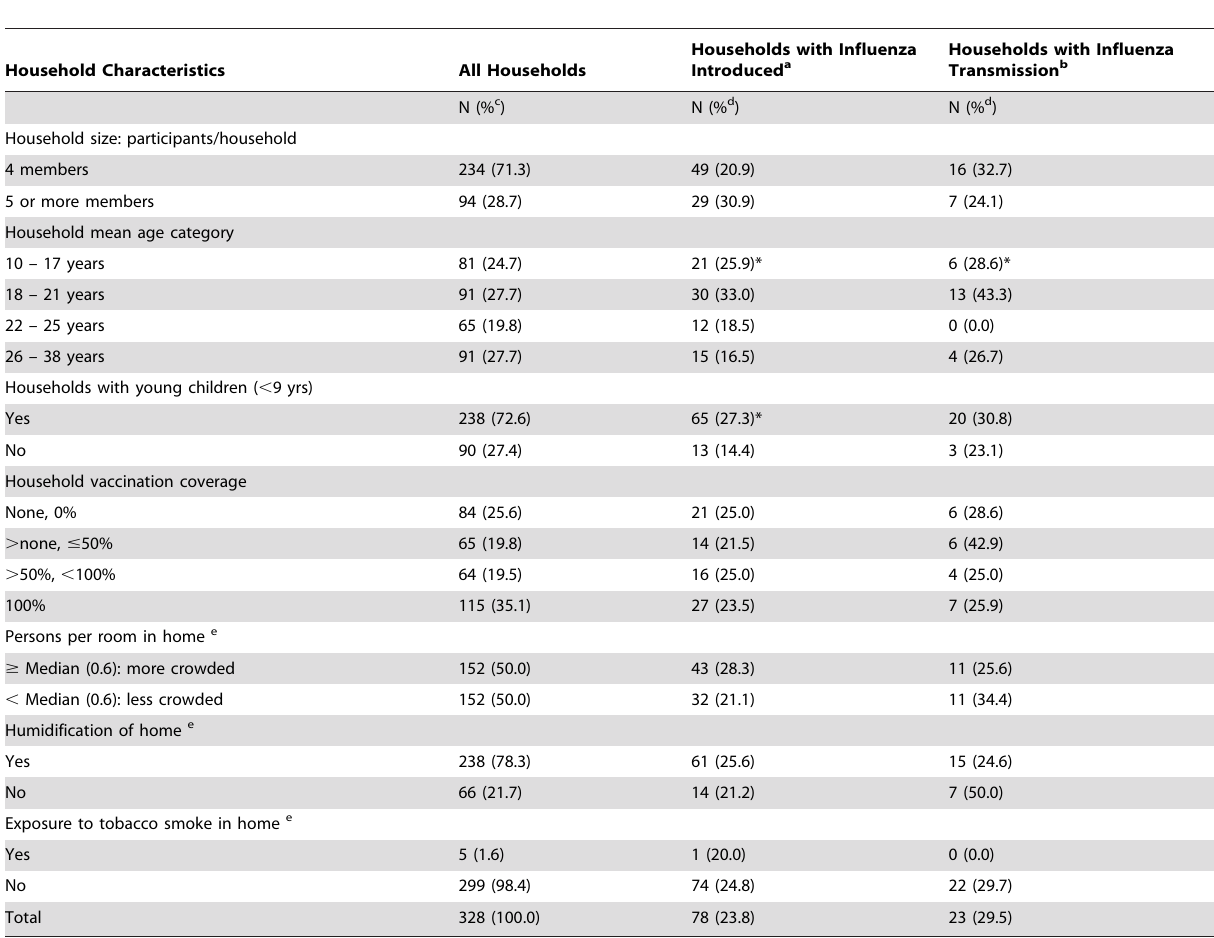
Table 2. Household characteristics and the distributions of households with influenza introduced a and